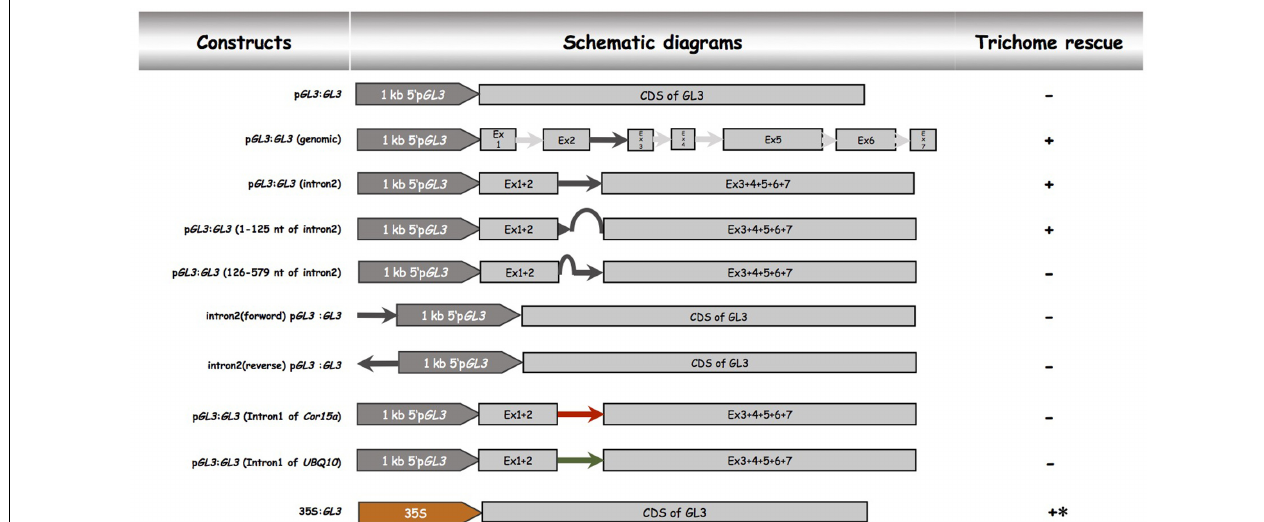
rescue (rescued lines/total number of